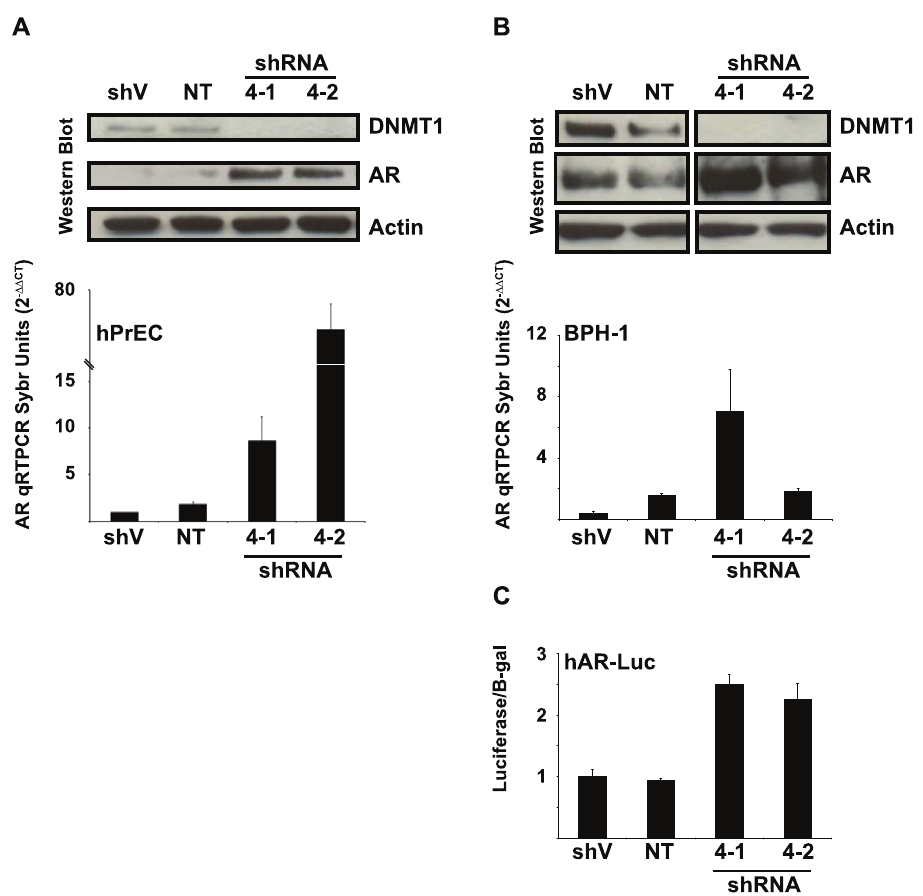
Figure 4. DNMT1 downregulation relieves AR Expression. (A) Primary cultures of human prostate epithelial cells (hPrEC) and (B) immortalized benign prostate epithelial cells (BPH-1) transduced with either control (shVector (shV) and shNon-targeting (NT)) or DNMT1 shRNA constructs. AR and DNMT1 protein expression relative to actin loading control were analyzed by Western blot. The exposures in (B) were taken from different sections of the same blot at the same intensity. AR transcription was analyzed using qRTPCR with readings done in triplicate (graphs A and B). Mean values are represented with standard error bars. (C) shRNA transduced BPH-1 cells (described in A and B) were transfected with the human AR promoter luciferase reporter (hAR-Luc) construct. The histograms represent the mean value of three independent experiments with the indicated standard deviation. Results were normalized to b -galactosidase (B-gal) expression from a co-transfected CMV promoter driven B-gal reporter construct. All western blots are representative of 3 separate experimental